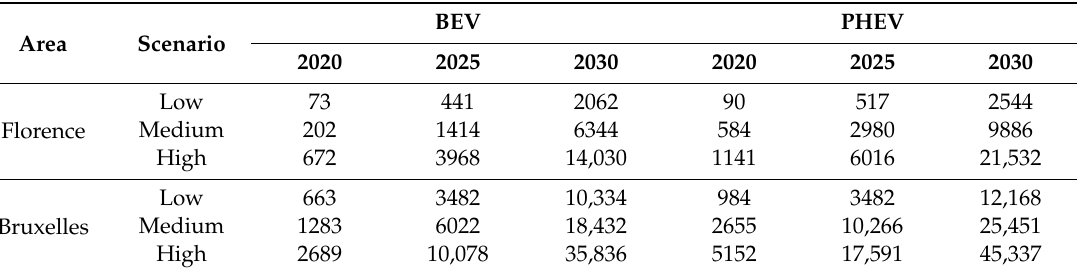
Table 4. Battery electric vehicle (BEV) and plug-in hybrid electric vehicle (PHEV) fleet forecasts for the area of Florence and Bruxelles municipalities—absolute figures.